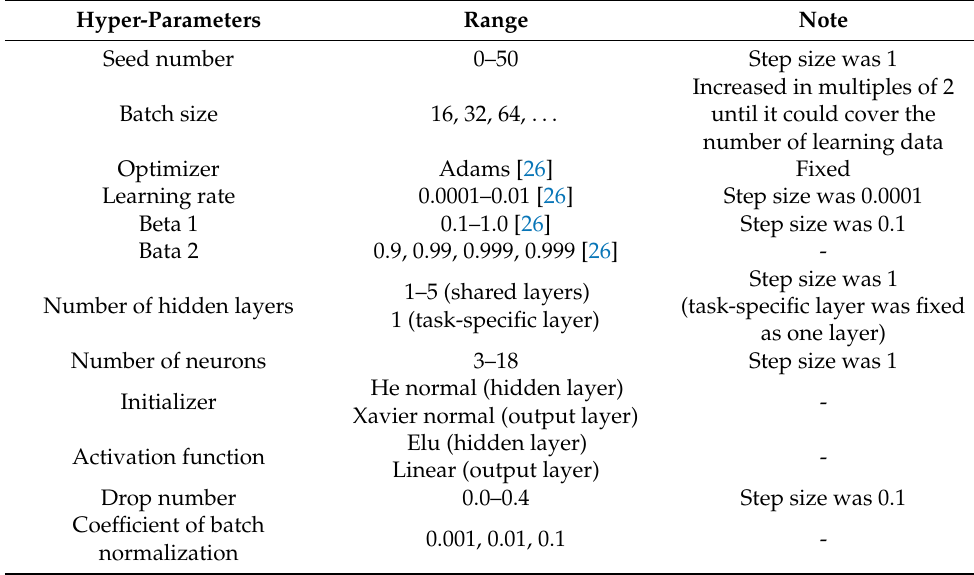
Table 7. Ranges of hyper-parameters obtained by hyper-band technique